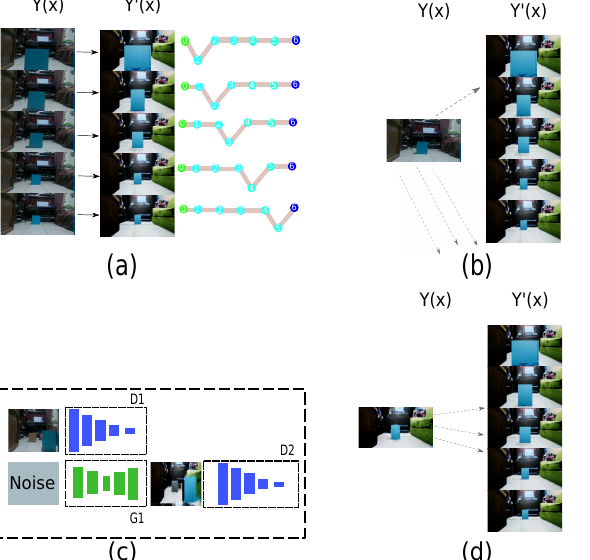
Figure 17. The importance of a GAN for connecting two domains. ( a ) one-to-one dataset. ( b ) One- to-one randomization of output in the dataset. ( c ) Module to change the domain. ( d ) Estimated image.